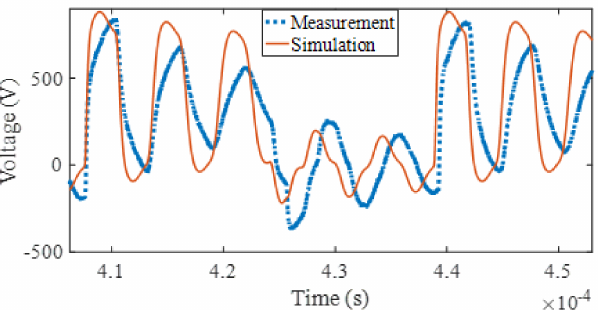
Figure 11. Comparation of the line-to-line overvoltage at the motor side with the model of low cable